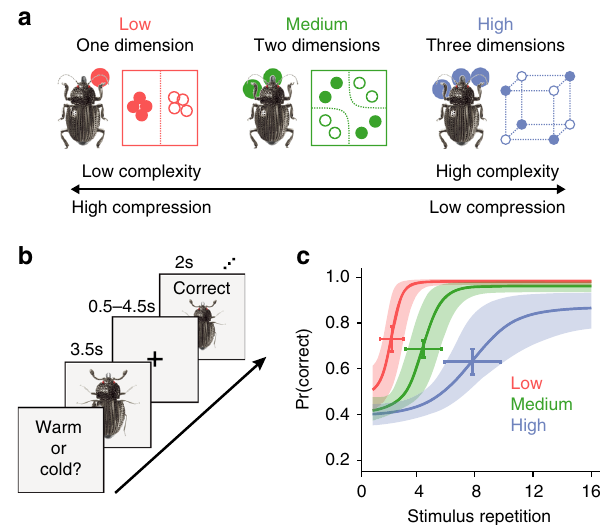
Fig. 1 Experimental schematic and behavioral results ( N = 23). a The learning problems differed in rule complexity (see Supplementary Table 1).